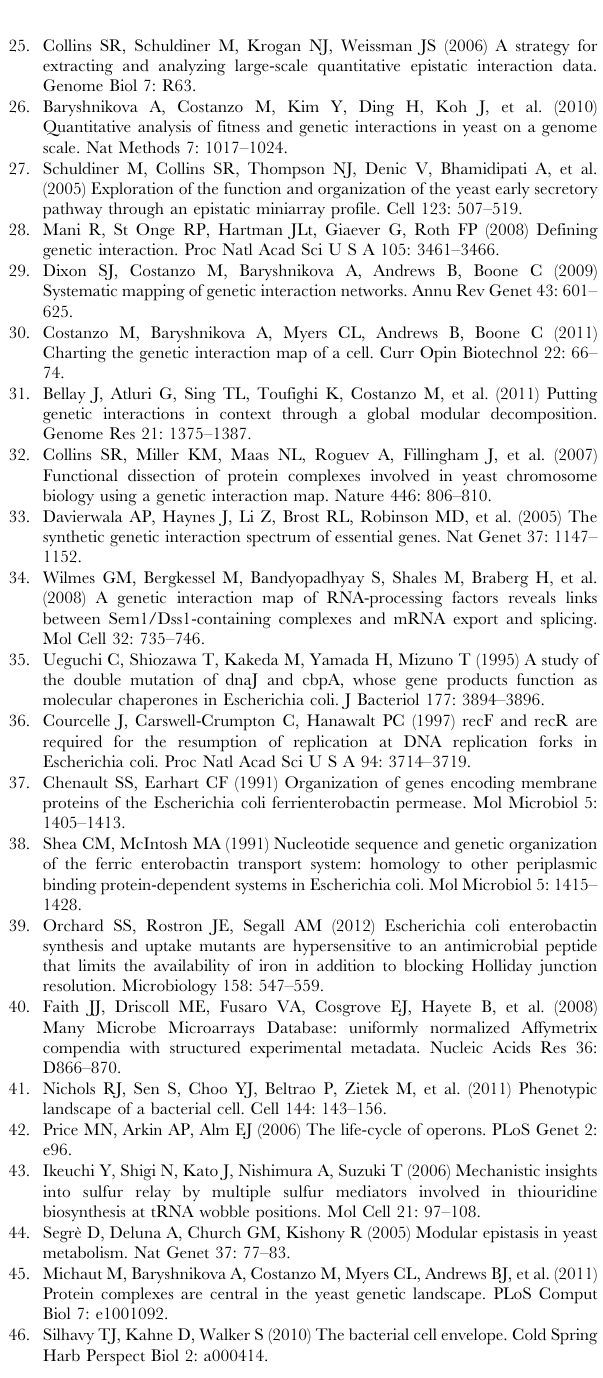
Table S15 Identification of several distinct, highly correlated clusters of bioprocesses with varying patterns of co-conservation. Table S16 List of bacterial strains and plasmids used in this